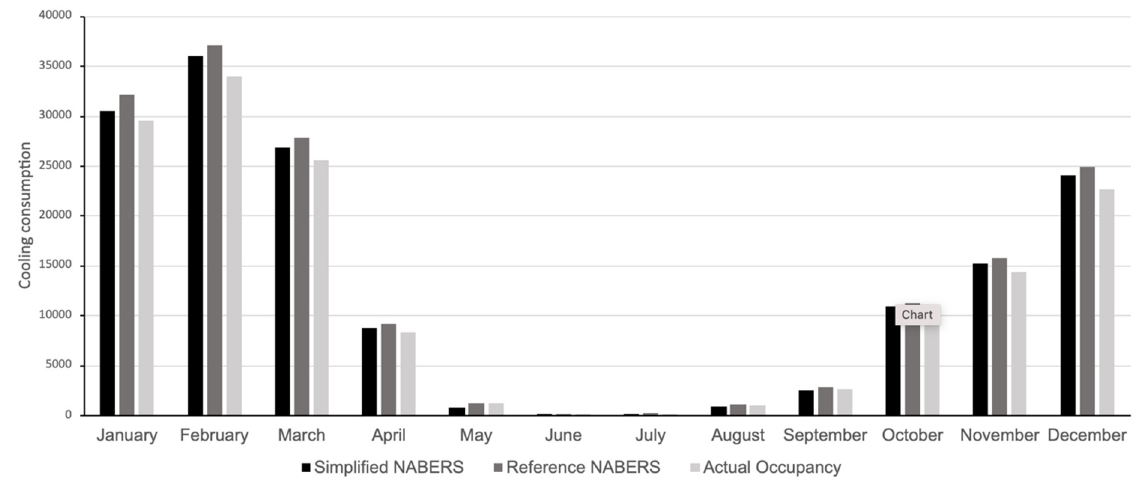
Figure 5. Comparison of the total monthly cooling needs in the two